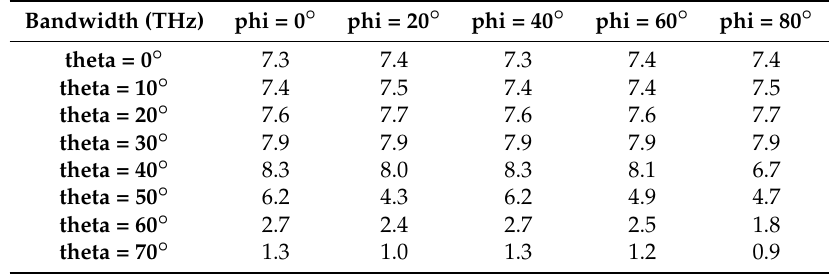
Table 1. Absorption bandwidth under the changes of the incident angle theta for TE incident wave.